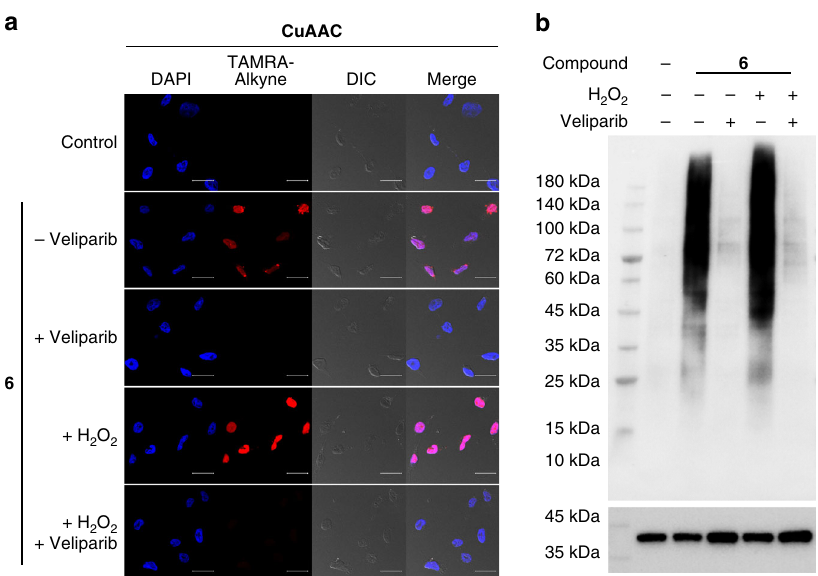
Fig. 4 Visualization and labeling of cellular protein PARylation by 6 . HeLa cells were pretreated for 20 min in the absence and presence of H 2 O 2 and 1 µ M veliparib. Following transient permeabilization with 0.01% Triton-X-100, cells were incubated with 100 μ M 6 for 45 min, followed by a confocal microscopic analysis through fi xation, permeabilization, and fl uorescent staining via click chemistry, CuAAC: copper(I)-catalyzed azide alkyne cycloaddition. DIC: differential interference contrast. Scale bars: 20 μ m, and by b immunoblot analysis of cell lysates as detected by a streptavidin-HRP conjugate following biotin conjugation via click chemistry. GAPDH as protein loading controls were detected by an anti-GAPDH antibody. Source data are provided as a Source Data fi